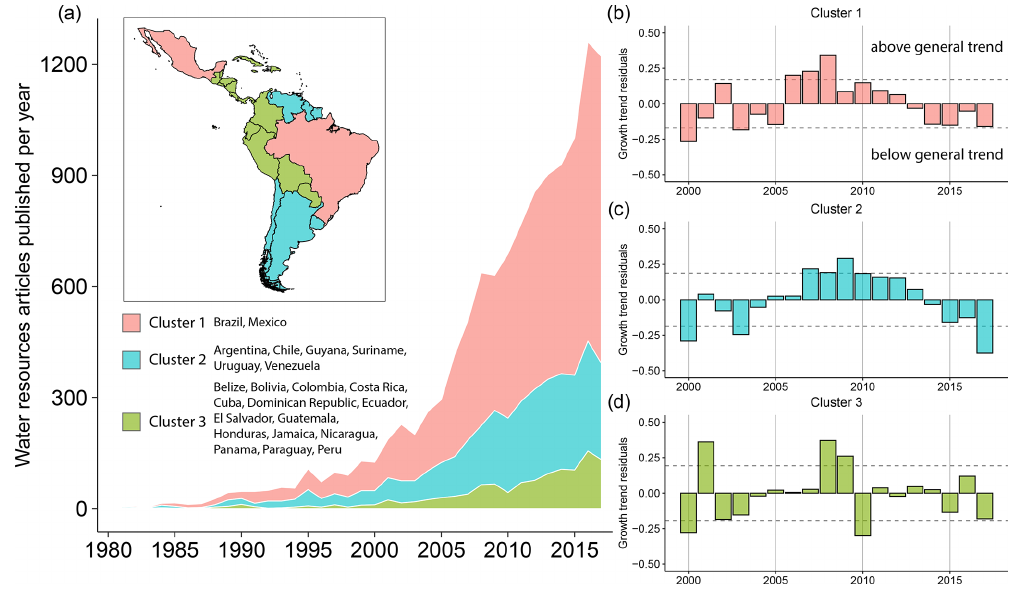
Figure 5. Growth of water resources research. (a) New articles per year for each socio-hydrologic cluster (inset). (b–d) Residual analysis estimating the deviation from the exponential trend for each socio-hydrologic